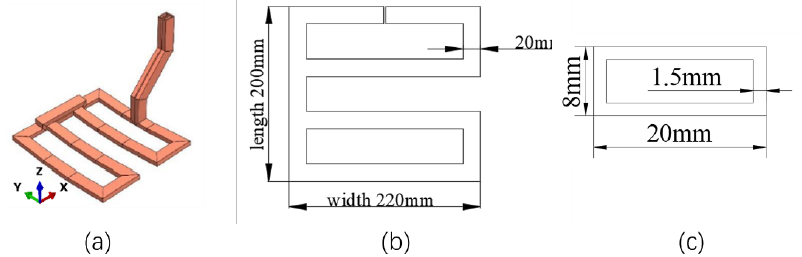
Figure 2. The shape of the inductor coil: ( a ) coil model; ( b ) main dimensions of the coil; and ( c ) cross section of the coil.